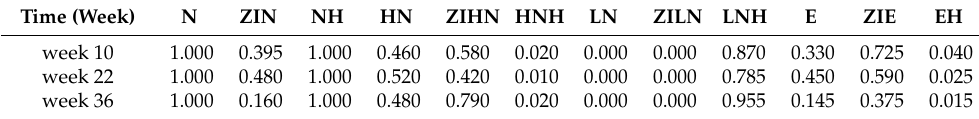
Table A1. KS-test p values for non-pregnant group ( N = 30) under 12 distributions at different weeks. Time